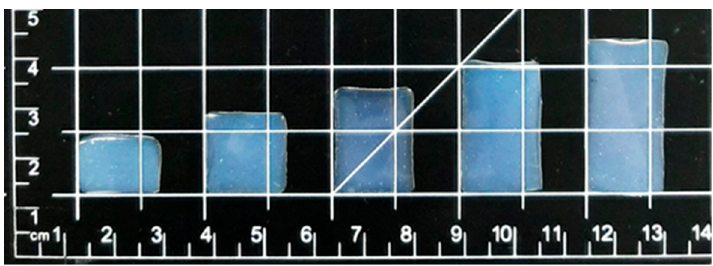
Figure 4. A picture of the different sized drug-loaded films without liver powder printed with the Biobot printer.